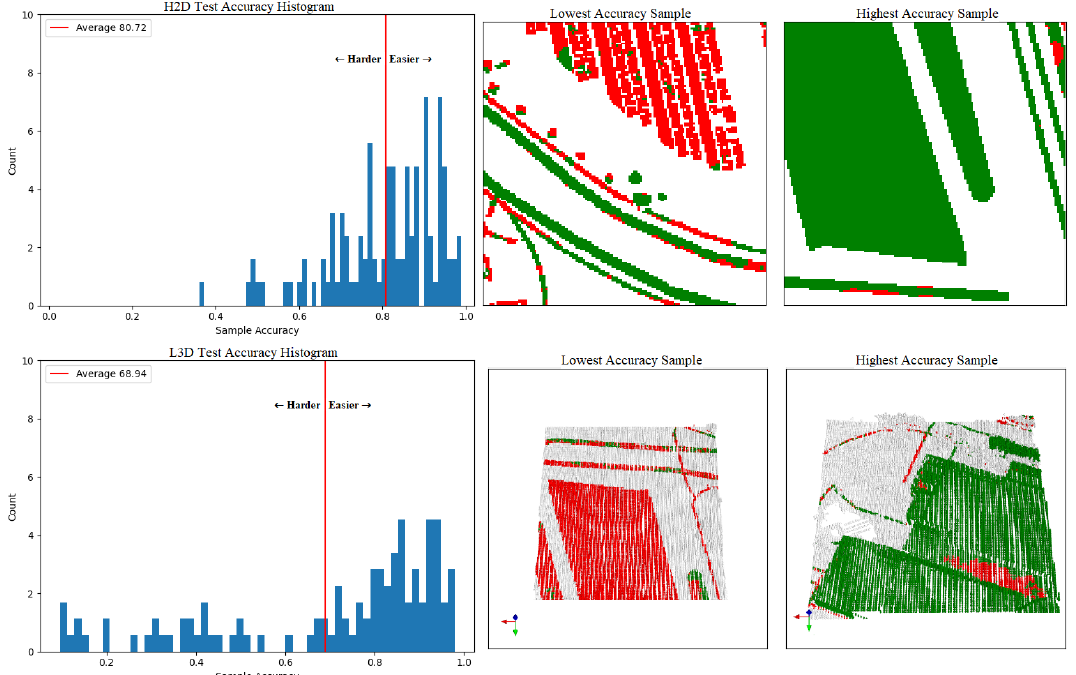
Figure 10. Histograms of test set accuracy over individual samples observed from H2D and L3D and examples of sample performance. ( Top ) H2D histogram along with the lowest and highest accuracy samples. ( Bottom ) L3D histogram along with the lowest and highest accuracy samples. Lowest and highest accuracy samples are colored by correct pixels/points (green), incorrect pixels/points (red), and masked unlabeled pixels/points (light